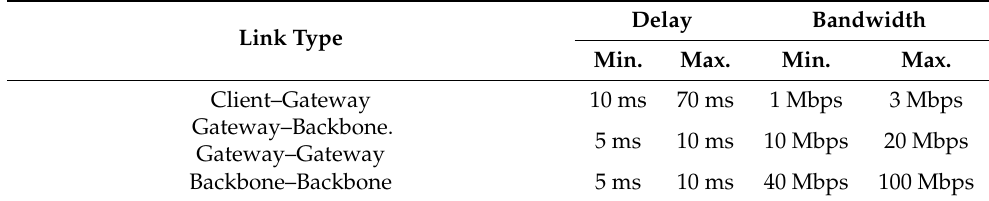
Table 3. Bandwidth and delays of AT&T